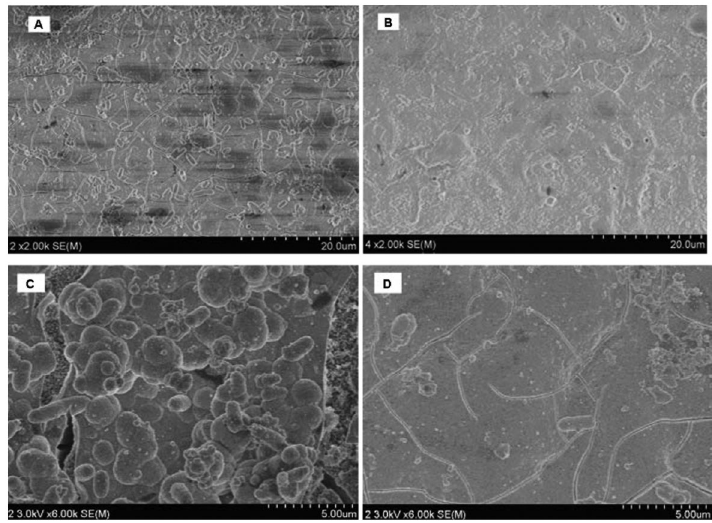
Figure 2. Microstructures of the surface of MAO- coated and uncoated magnesium alloy after immersion for 3 and 14 days, A , B , Uncoated and MAO-coated samples after immersion for 3 days, respectively. C , D , Uncoated and MAO- coated samples after immersion for 14 days, respectively. MAO: micro-arc